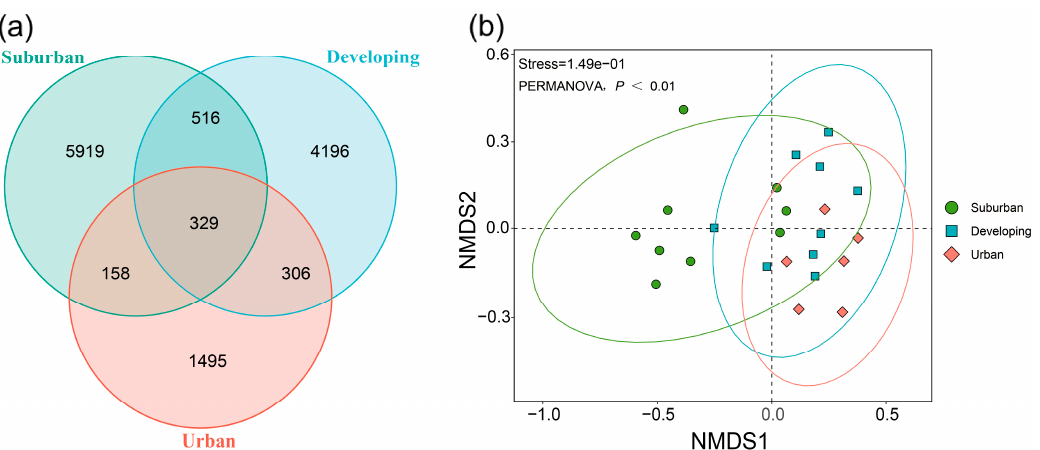
Figure 1. Changes in microbial community composition and diversity along the urbanization gradient. Venn diagram ( a ) and NMDS (Non-metric multidimensional scaling) analysis ( b ) of phyllosphere microbiota of camphor trees with different urbanization levels. Suburban, developing, and urban stand for the corresponding urbanization level for sampling.